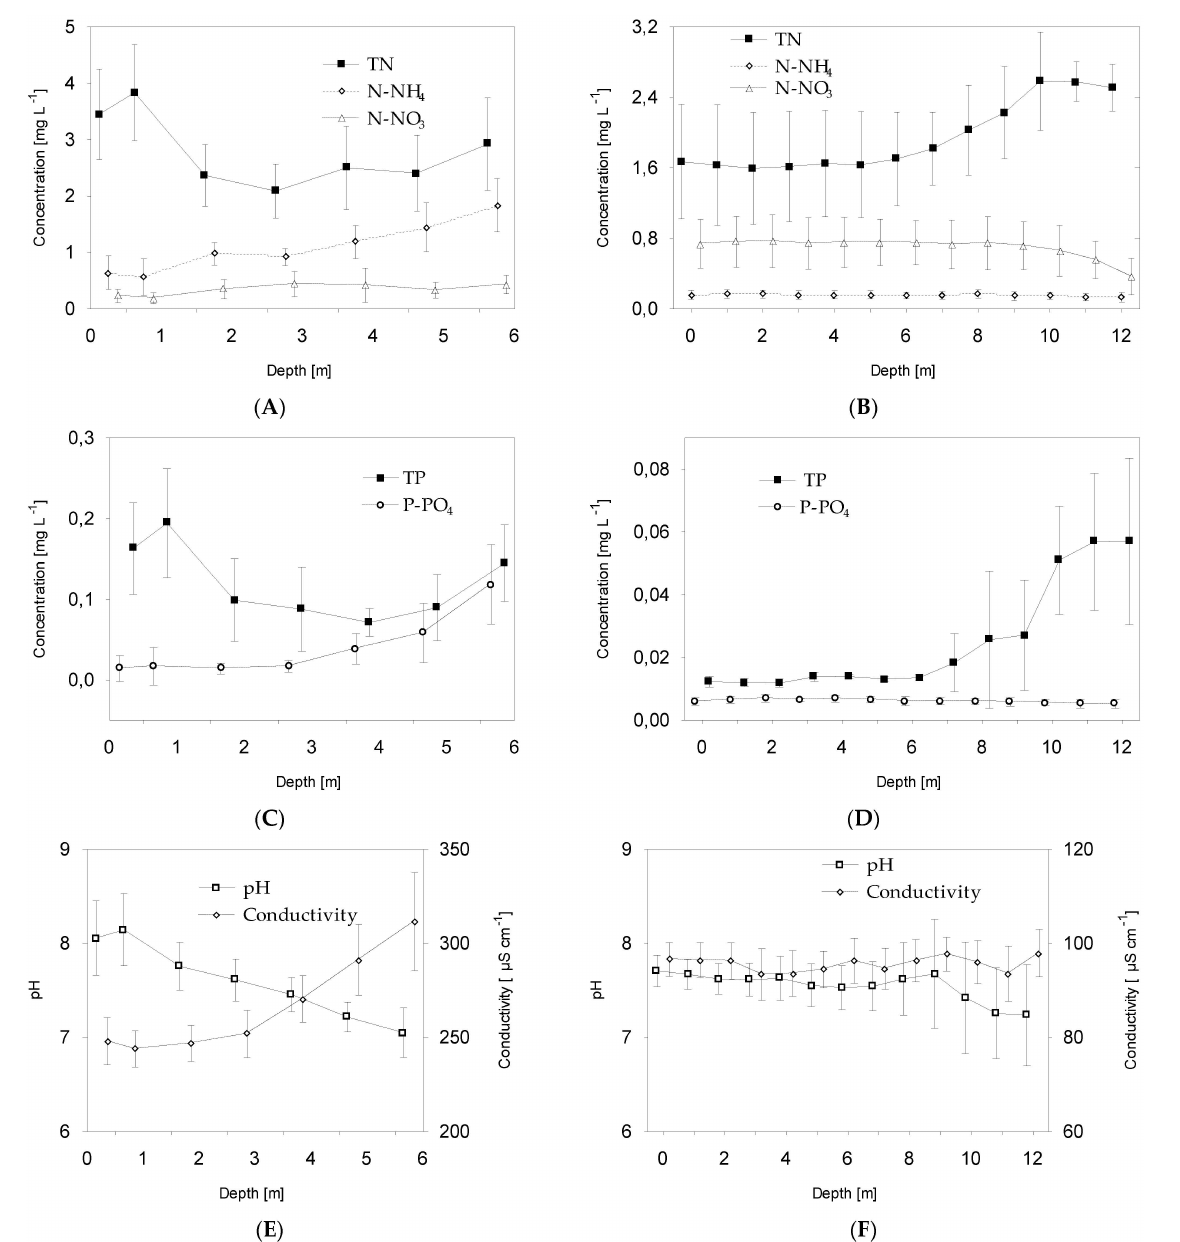
Figure 5. Mean values ( ± standard deviations) of selected chemical and physicochemical parameters of water in Lake Glinki ( A , C , E ) and Lake Piaseczno ( B , D , F ). Explanations: TN, total nitrogen; N-NO 3 , nitrate nitrogen; N-NH 4 , ammonium nitrogen; P-PO 4 , phosphate phosphorus; TP, total